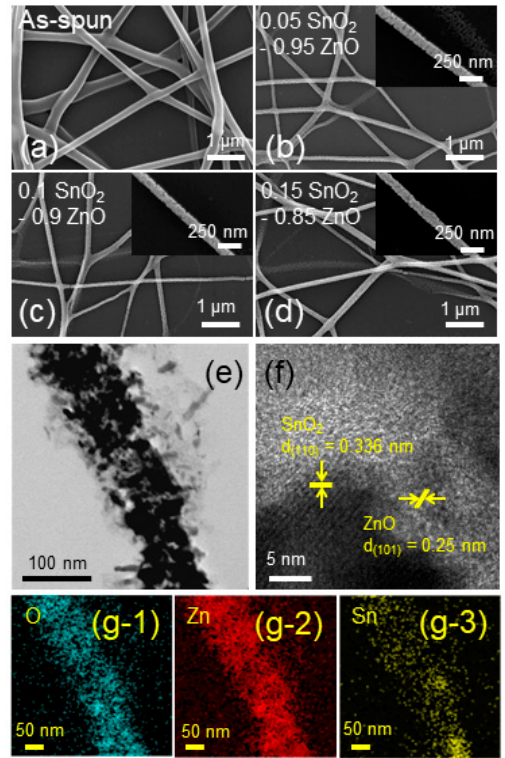
Figure 2. Field-emission scanning electron microscopy (FE-SEM) micrographs of ( a ) as-spun 0.1 SnO 2 -loaded ZnO NFs and calcined, ( b ) 0.05 SnO 2 -loaded ZnO NFs, ( c ) 0.1 SnO 2 -loaded ZnO NFs, and ( d ) 0.15 SnO 2 -loaded ZnO NFs. Insets in ( b – d ) show corresponding higher magnification FE-SEM images. ( e ) Low-magnification TEM image and ( f ) high-resolution TEM image of 0.1 SnO 2 -loaded ZnO NFs. ( g ‐ 1 ), ( g ‐ 2 ) and ( g ‐ 3 ) energy ‐ dispersive X ‐ ray spectroscopy (EDS) O, Zn and